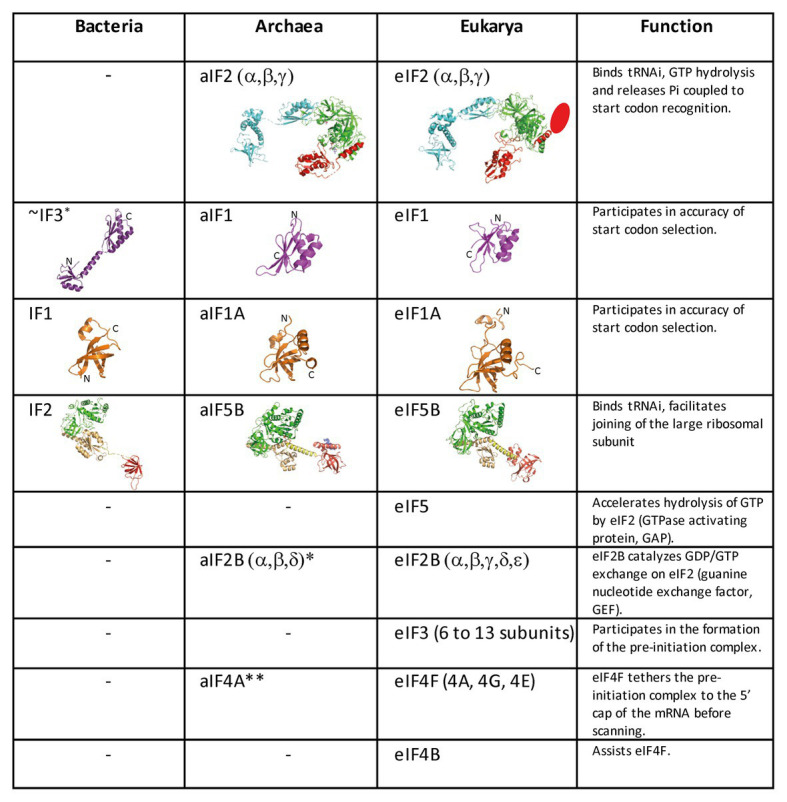
Translation initiation factors in the three domains of life. The structures of the archaeal translation initiation factors and of their orthologues in eukaryotes and bacteria (when present) are shown. e/aIF2 is colored as in Figure 1. The unknown structure of the N-domain specific of eukaryotic eIF2β is shown as an oval. The structure of aIF2 is from PDB 3V11 (Schmitt et al., 2012), those of aIF1 and aIF1A are from Coureux et al. (2016). The structures of eIF2, eIF1, and eIF1A are from PDB 6FYX (Llacer et al., 2018). IF1 is from PDB 3I4O (Hatzopoulos and Mueller-Dieckmann, 2010). Bacterial IF3 is a two-domain protein. The correspondence between IF3 and e/aIF1 is based on a structural and functional resemblance of the IF3 C-terminal domain with e/aIF1. Despite this resemblance, the topologies of the two α–β folds are different. This suggests that they do not derive from a common ancestor. aIF5B is from PDB 1G7T (Roll-Mecak et al., 2000), eIF5B is from PDB 4N3N (Kuhle and Ficner, 2014), and IF2 is from PDB 5LMV (Hussain et al., 2016). The color code for e/aIF5B/IF2 is as follows: G-domain and domain II in green, domain III in light orange, linker in yellow, and domain IV in red. The specific archaeal helix in domain IV is shown in blue. *The catalytic γ and ε subunits of eIF2B are missing in archaea. The function of the eIF2B α, β, δ homologues in archaea is not clear and may be unrelated to translation initiation (Dev et al., 2009; Gogoi et al., 2016). **The aIF4A orthologue is present in many archaea. However, deletion of the corresponding gene in Haloferax volcanii showed only a small phenotype (Gäbel et al., 2013).